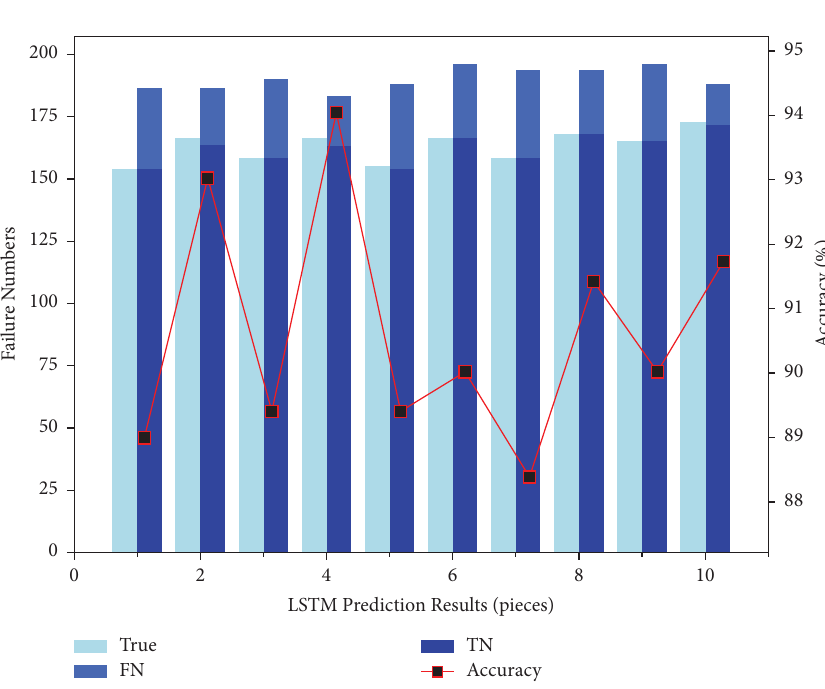
Figure 10: Te failure prediction result of the AI model.